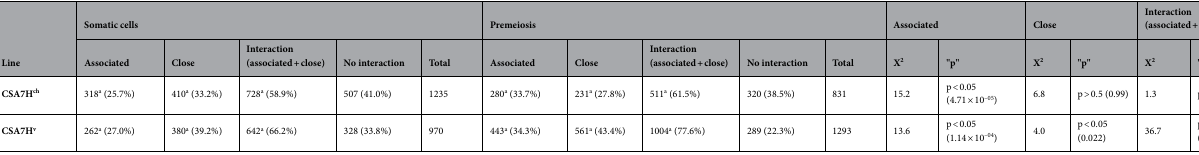
Table 2. Total number and percentage of somatic and premeiotic cells analysed to study chromosome interactions between H. chilense and H. vulgare homologous chromosomes added to wheat ( T. aestivum cv. chinese spring, CS) lines. The significance (p value) of the data between somatic and premeiotic cells at the same level of chromosome interaction within the same wheat line was confirmed by Student’s t test. The robustness of the data was indicated by the X 2 . Data with the same letter within a column represent no significantly differences (when p < 0.05) among both wheat addition lines at the same level of chromosome